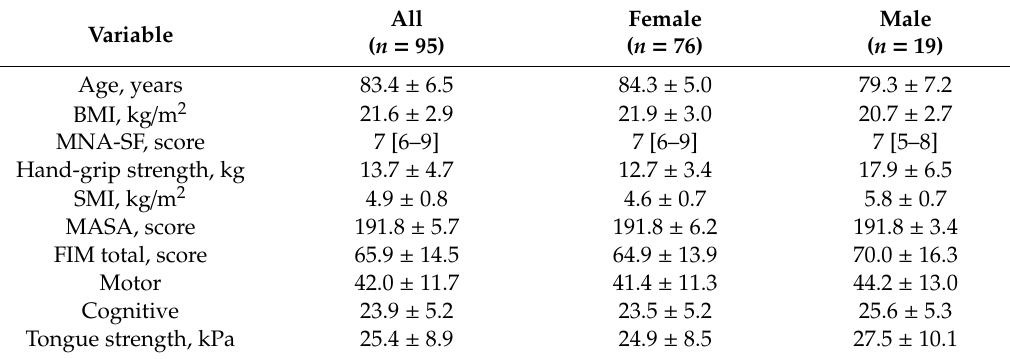
Table 1. Baseline characteristics at admission to the rehabilitation